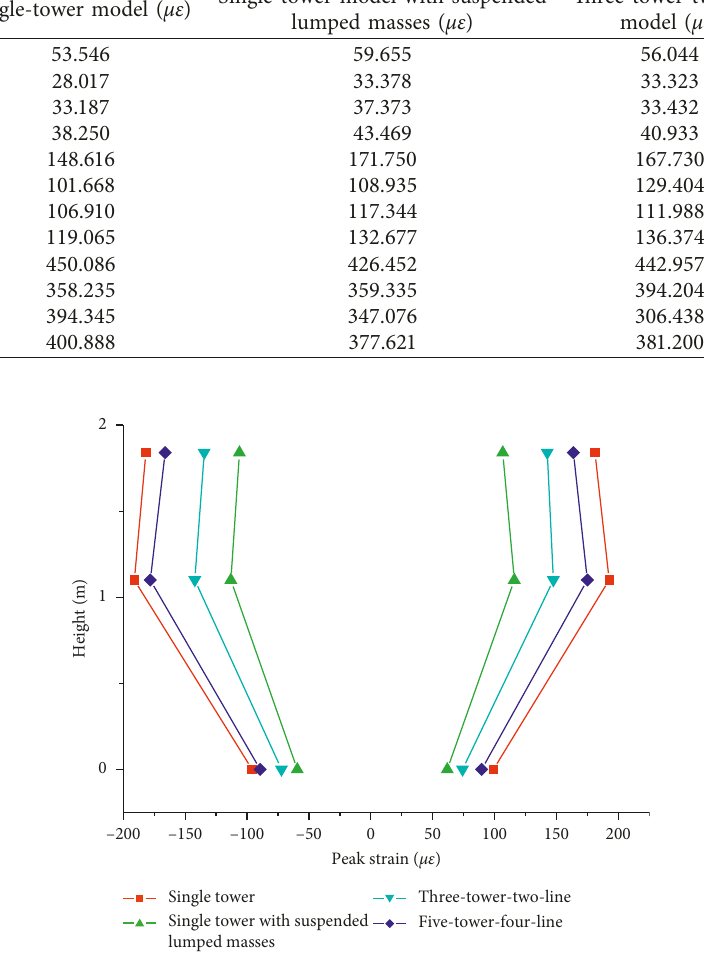
Figure 27: Transverse peak strain responses of the four counterweight models under a 0.21g artificial